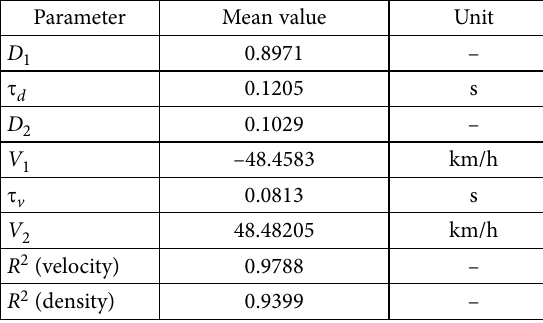
Table 6. Density and velocity error